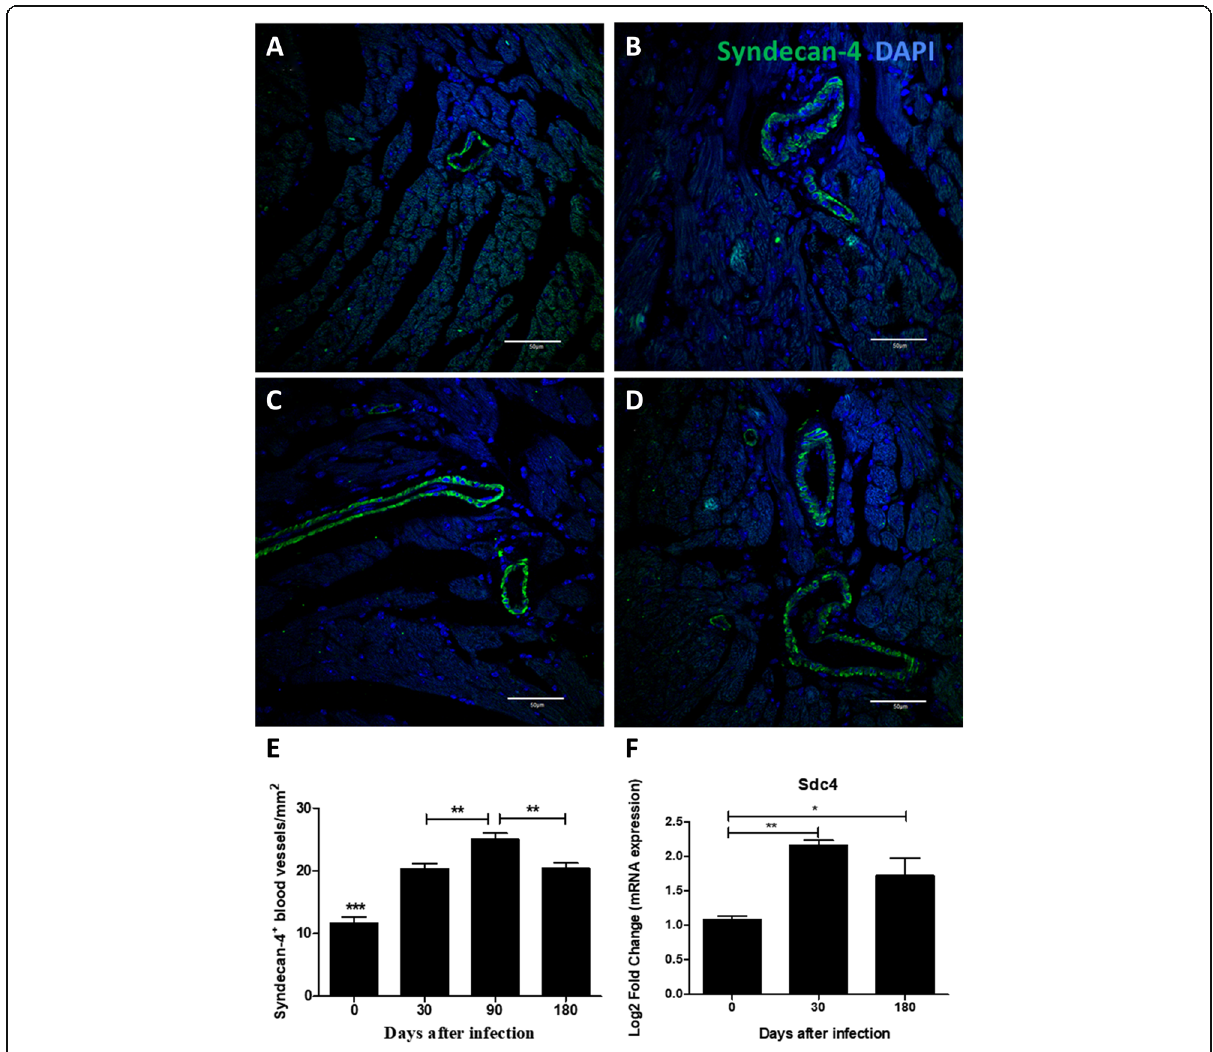
Fig. 2 Expression of syndecan-4 in the heart is increased after T. cruzi infection. Heart sections of uninfected ( a ) and T. cruzi -infected mice, 30 ( b ), 90 ( c ) and 180 ( d ) days after infection were stained with anti-syndecan-4 antibody (green) and DAPI (blue) for nuclei, and observed by confocal microscopy. e , Quantification of syndecan-4 + blood vessels in heart sections. Data represent the mean ± SEM of 5 – 6 mice/group. f, Evaluation of cardiac Sdc4 gene expression by qRT-PCR. ** P < 0.01; *** P < 0.001 compared to other